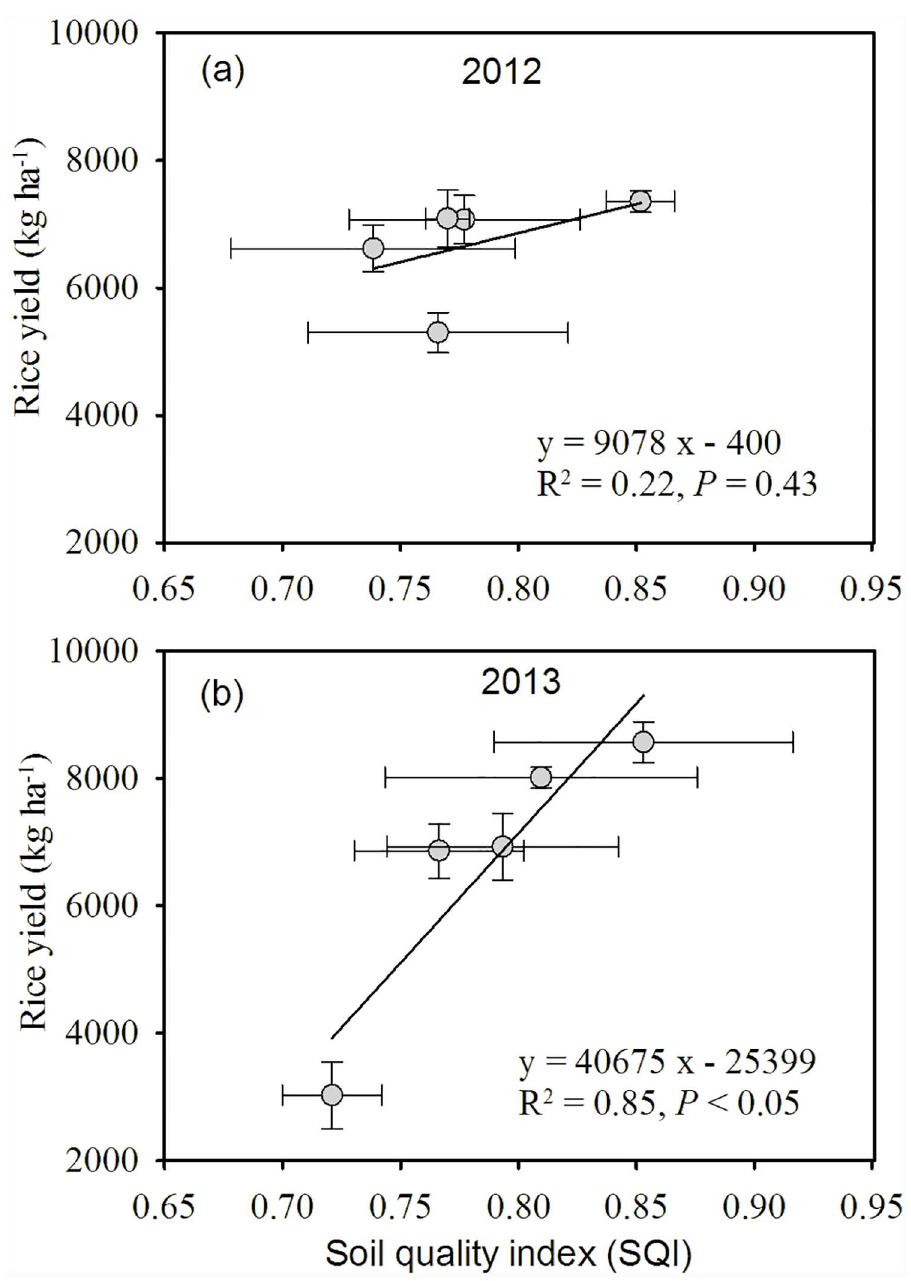
Fig 8. Relationships between Soil Quality Index (SQI) values and rice yields in 2012 and